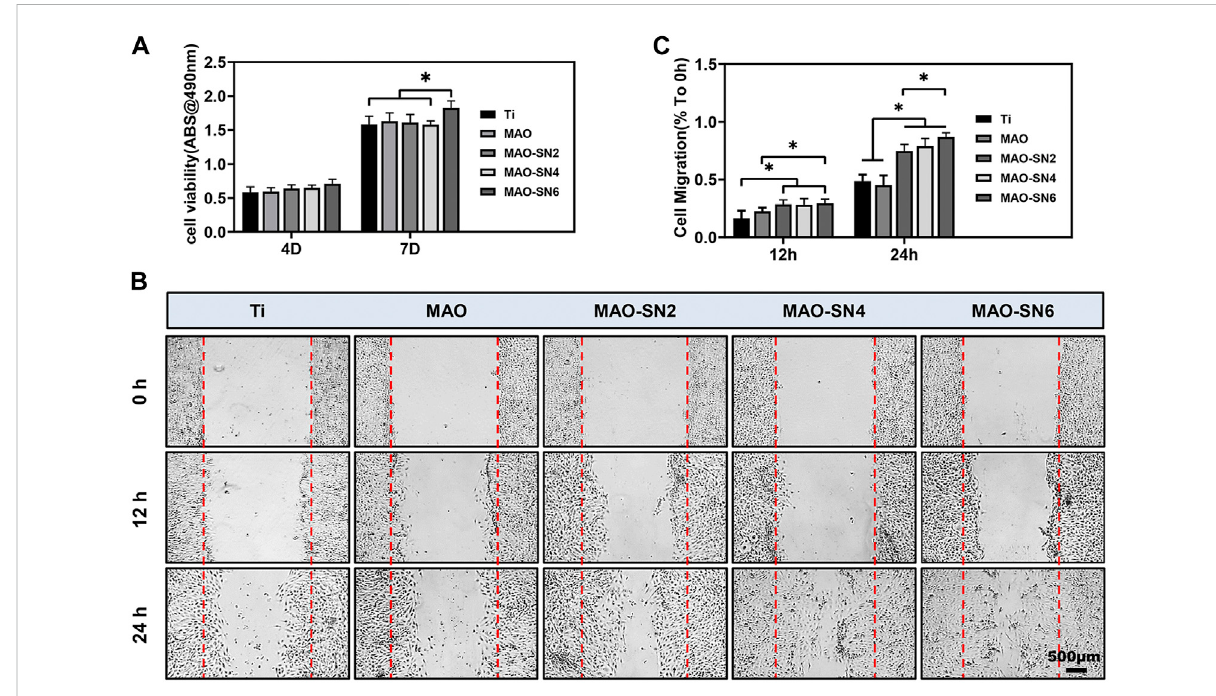
FIGURE 7 (A) ViabilityofHUVECsindifferentextractsafter4and7 d. (B) HUVECmigrationafter0,12,and24 h. (C) Quantitativeanalysisofmigrationareas after incubation in different extracts for 12 and 24 h. * p < 0.05.